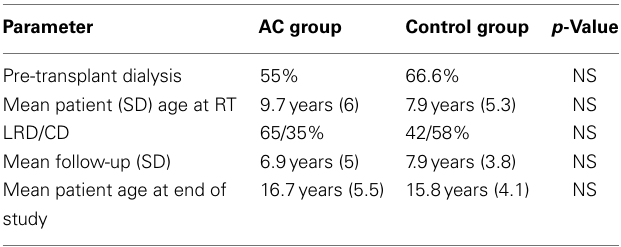
Table 1 | Demographic characteristics of transplanted children with an AC and transplanted controls